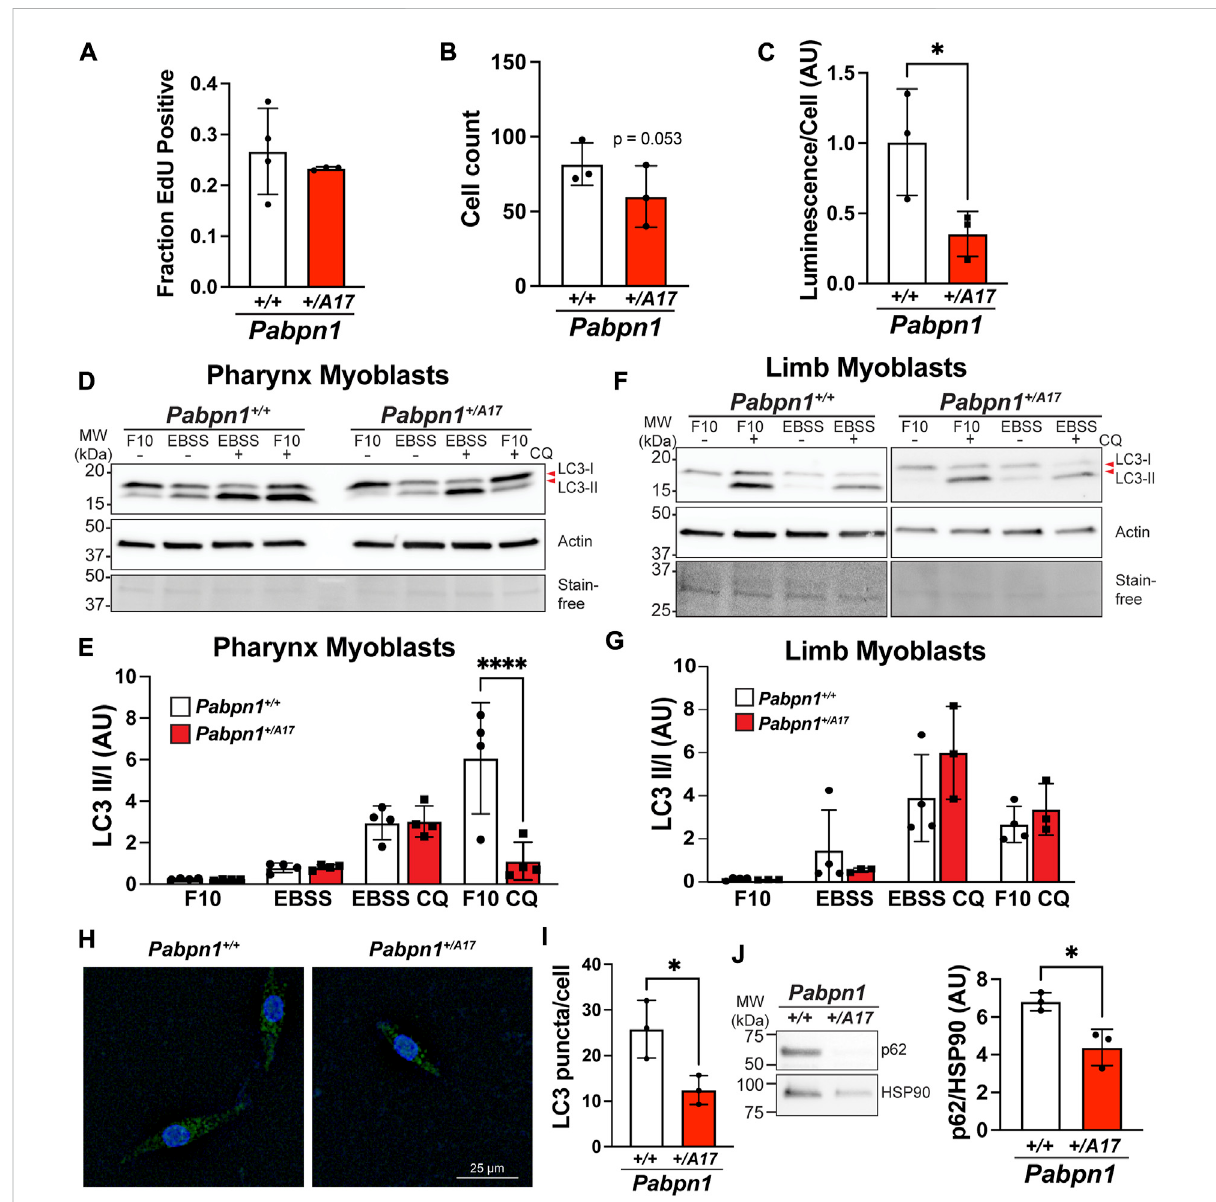
FIGURE 5 Impaired basal autophagy in pharyngeal but not limb myoblasts isolated from Pabpn1 +/A17 mice. (A) Fraction of EdU positive cells showing no signi fi cant difference in pharyngeal myoblasts from Pabpn1 +/A17 relative to Pabpn1 +/+ mice. (B) Total number of cells as quanti fi ed by counting DAPI- stained nuclei showing a trend toward fewer total cells in Pabpn1 +/A17 relative to Pabpn1 +/+ mice. (C) Cell viability reported as Luminescence per cell revealingasigni fi cantdecreaseinviablecellsinpharyngealmyoblastsfrom Pabpn1 +/A17 comparedto Pabpn1 +/+ mice. (D) Immunoblotstoassay autophagy in pharyngeal myoblasts from Pabpn1 +/+ and Pabpn1 +/A17 mice grown in normal growth medium (F10) or under starvation conditions (EBSS)withorwithouttheautophagosome-lysosomefusioninhibitorchloroquine(CQ).BlotswereprobedwithanantibodytoLC3-BtodetectLC3- I and LC3-II, an antibody to β -actin (Actin) as a negative control, and imaged using stain free technology (Stain-free) as a loading control. (E) Quanti fi cation of blot shown in D revealing a signi fi cant decrease in Pabpn1 +/A17 myoblasts in F10 + CQ conditions. (F) Immunoblots quantifying autophagy in limb myoblasts. (G) Quanti fi cation of immunoblot shown in F revealing no difference in Pabpn1 +/+ and Pabpn1 +/A17 myoblasts. (H) Representative image of Pabpn1 +/+ and Pabpn1 +/A17 pharyngeal myoblasts immunostained with an antibody to LC3. Bar = 25 µm. (I) Quanti fi cation immunostainforLC3revealingasigni fi cantdecreaseinLC3punctapercellin Pabpn1 +/A17 pharyngealmyoblasts. (J) Representativeimmunoblotand quanti fi cation p62 protein in pharyngeal myoblasts grown in F10 medium and treated with CQ revealing a signi fi cant decrease in p62 in Pabpn1 +/A17 cells. Immunoblot probed with an antibody to HSP90 was used as a loading control. Shown is mean ± SEM for n = 3 – 4 mice. Statistical signi fi cance was determined using t-test or one-way ANOVA (**** p < 0.0001, * p < 0.05).